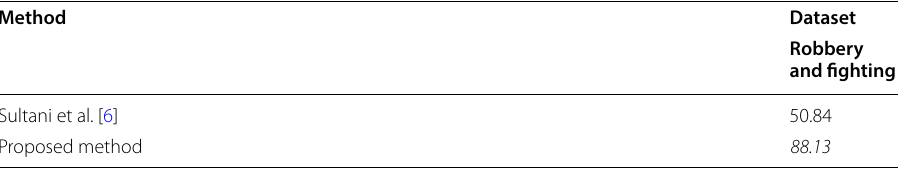
Table 5 The accuracy (%) evaluation of a Multi-events tested video from youtube between full-frame and our proposed locality learning